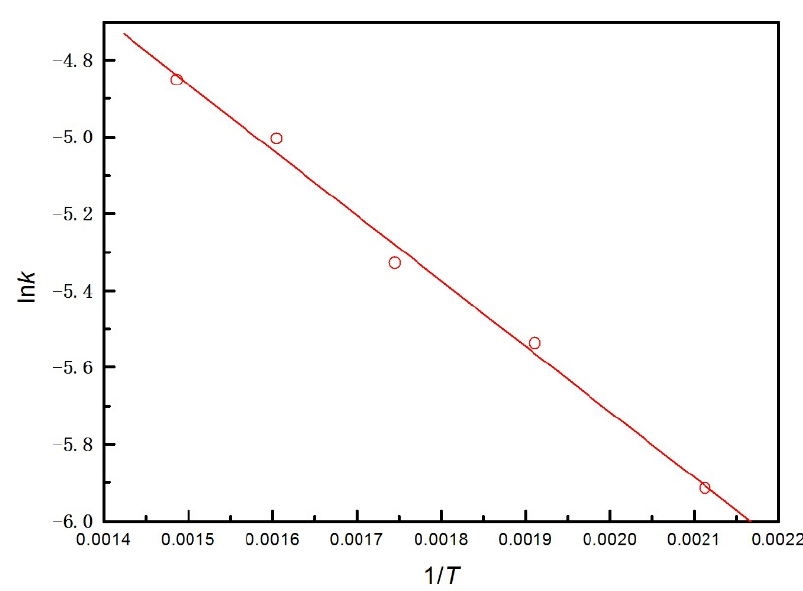
Figure 5. Arrhenius plots for the revolution of the internal diffusion controlling step. Table 2. Fitting results of lnk vs. 1/ T Fitting Parameters